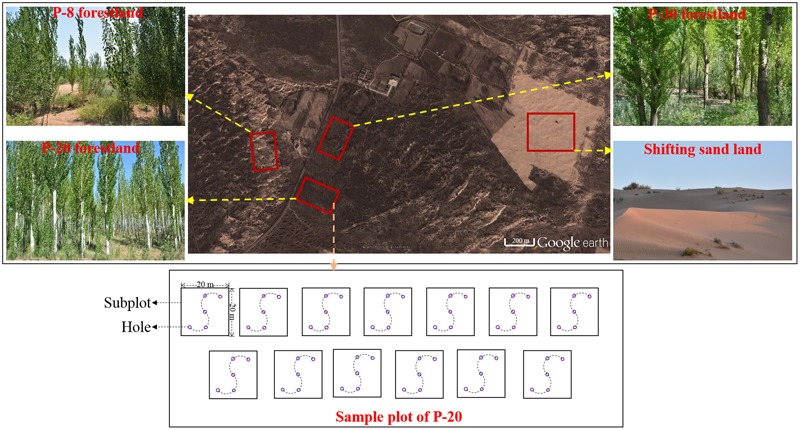
Distribution of the four sample plots in the study area and the relationships between sample plot, subplot and hole. The satellite image was obtained from Google Earth and was taken in January 2013. Other pictures were taken by YG in September 2015.